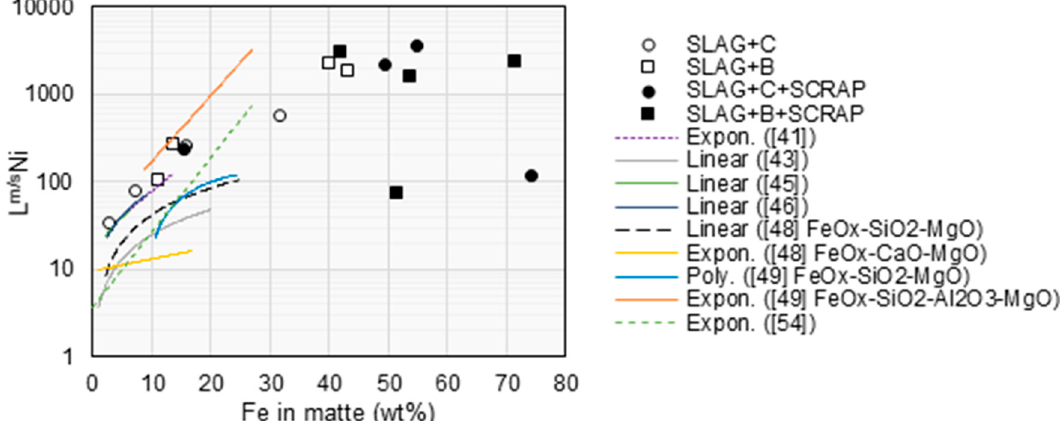
Figure 7. The distribution coefficient of nickel between matte and slag as a function of matte grade at 1400 °C. Multiple other equilibrium studies [43,45,46,48,49,54] and kinetic study by Ruismäki et al. [41] were added in the figure.